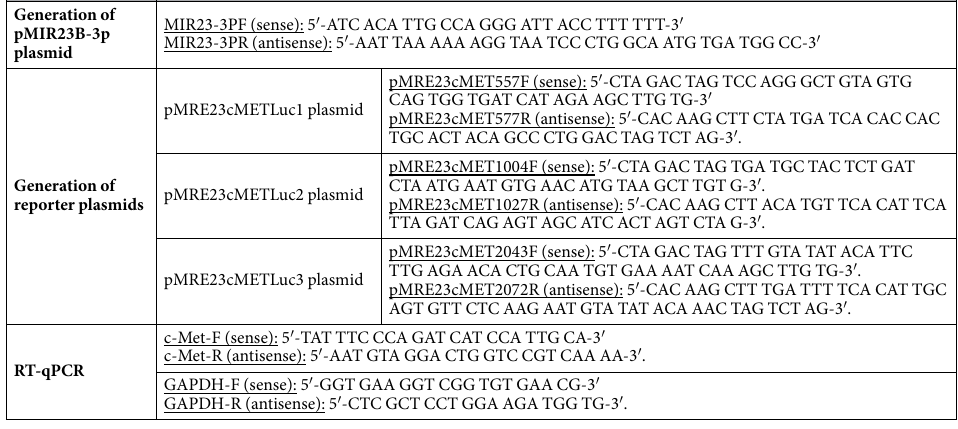
Table 1. Oligonucleotides used in this